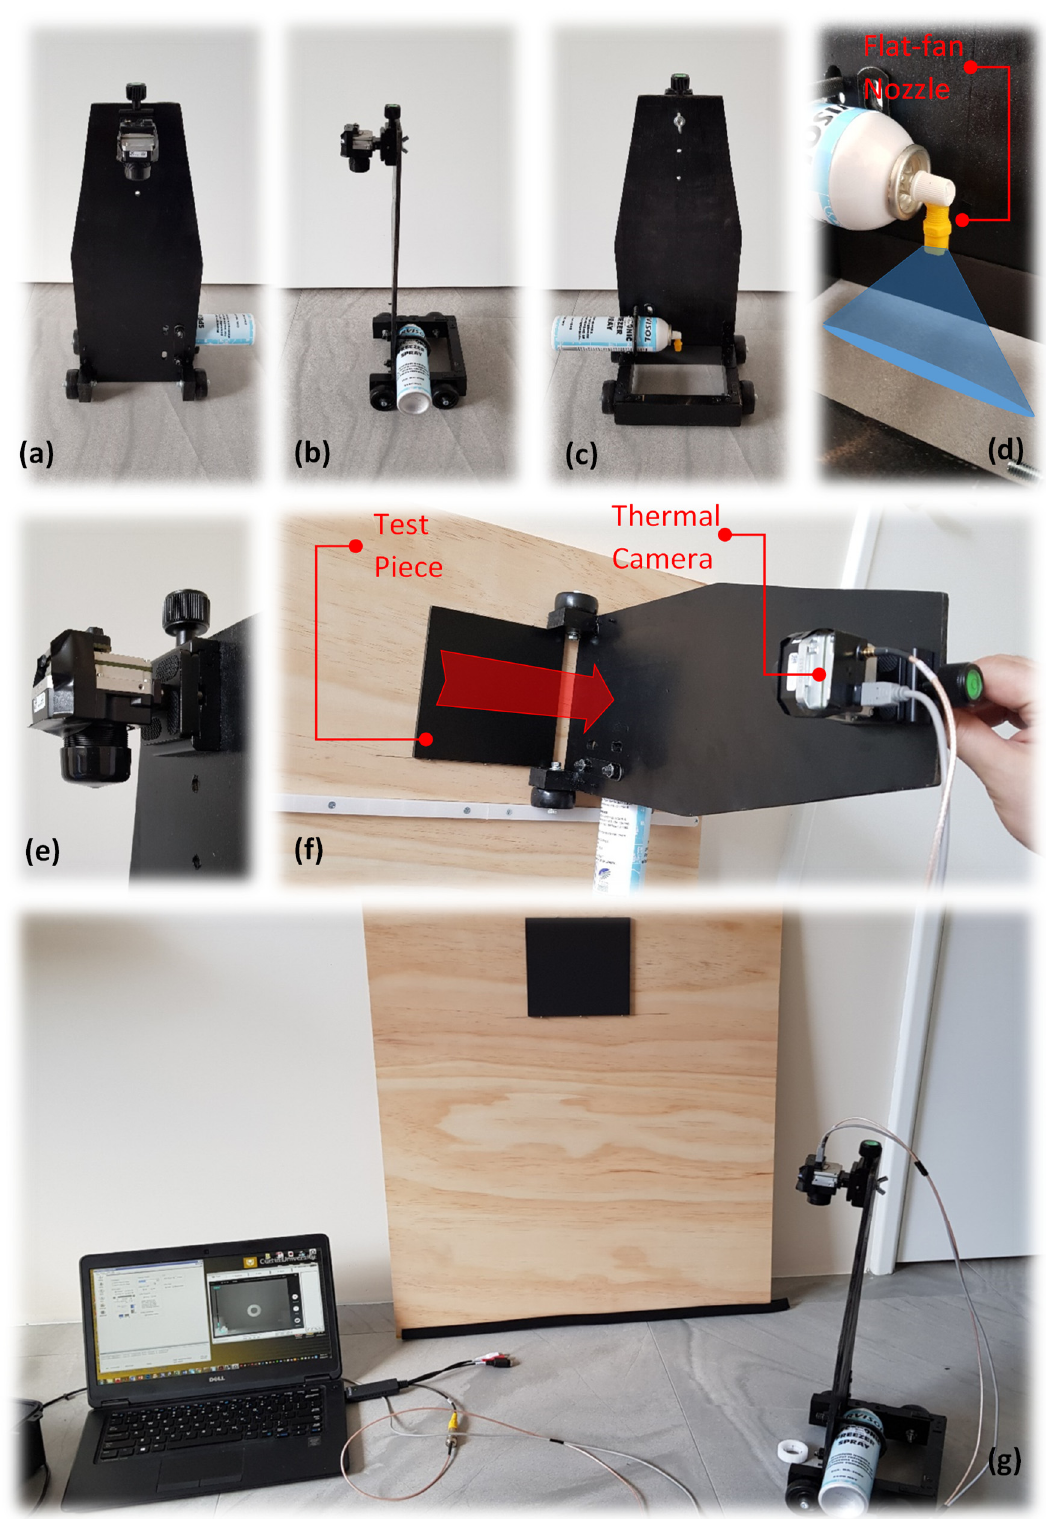
Figure 2. ( a ) carrier front view; ( b ) carrier side view; ( c ) carrier back view; ( d ) cooling medium spray with customised flat-fan nozzle; ( e ) thermal camera; ( f ) carrier linear movement over the test piece; ( g ) experimental setup [2], reproduced with permission from authors own work, Sub-surface metal loss defect detection using cold thermography and dynamic reference reconstruction (DRR). Structural Health Monitoring, 2021: p. 1475921721999599.